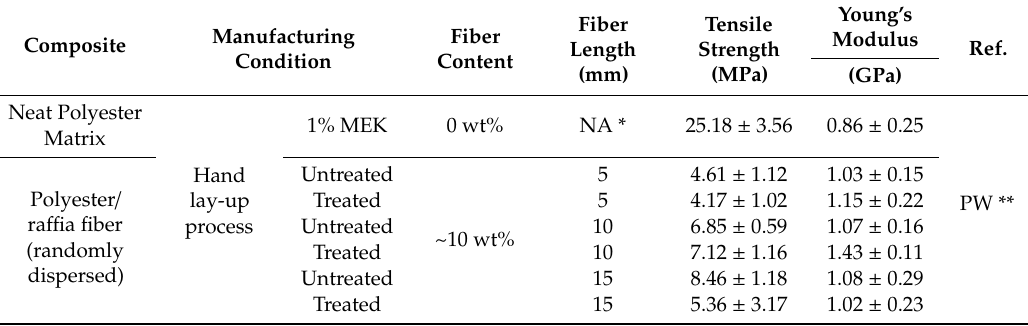
Table 2. Results of tensile tests of samples of Ra ffi a fiber polyester